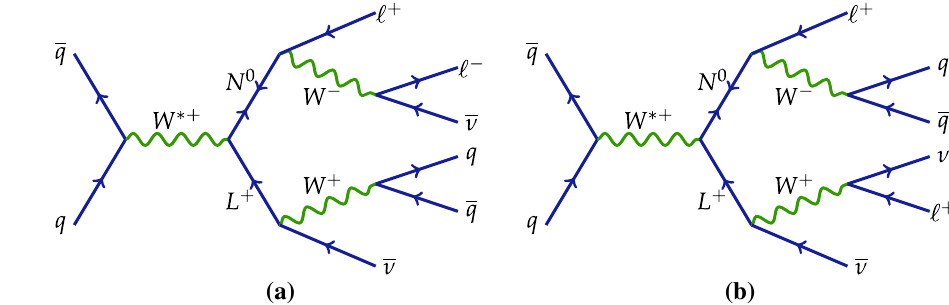
Fig. 1 Feynman diagrams of the dominant production process in the a opposite-charge and b same-charge final-state